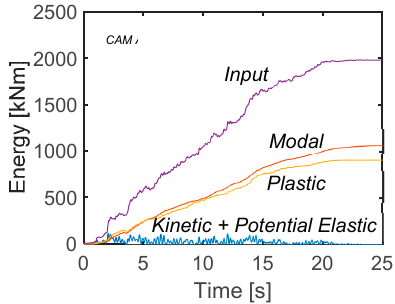
Figure 18. Bending moment-rotation response of C1 ground storey column belonging to A5 alignment around its strong flexural axis in retrofitted conditions.